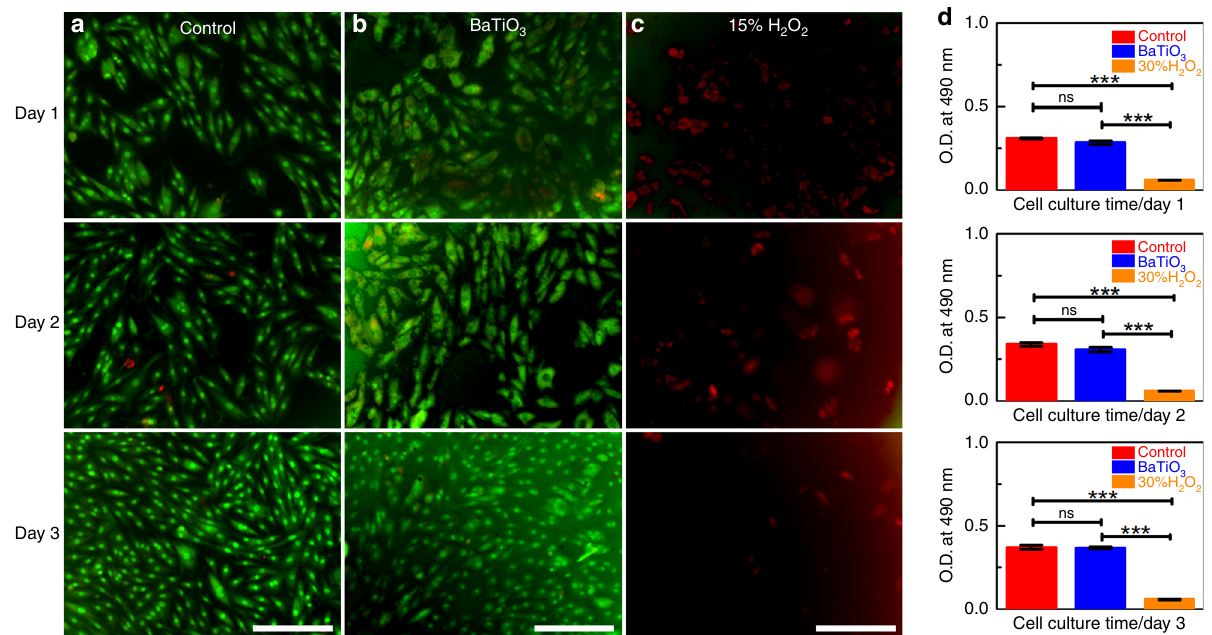
Fig. 6 Cytotoxicity characterization. Cell proliferation and morphology with different tissue culture media for 1, 2, and 3 days. AO/EB staining of A7r5 cells grown in a pure tissue culture, b tissue culture with BTO nanoparticles in concentration of 1 mg mL − 1 , and c tissue culture with 15% volume fraction H 2 O 2 . d Viability of A7r5 cells in different tissue culture measured by MTT assay. NS = p > 0.05, *** p < 0.01 ( t -test at each timepoint). Scale bars are 200 μ m. Error bars = standard deviation ( n =